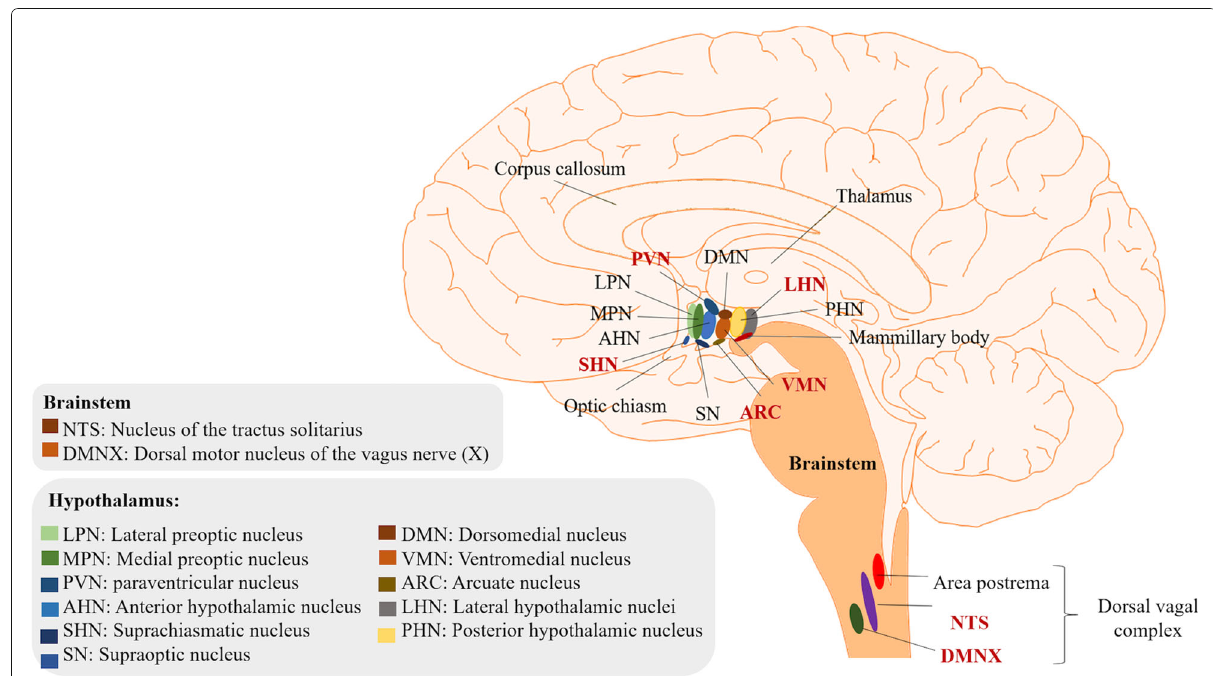
Fig. 1 Key hypothalamic nuclei and other areas involved in glucose homeostasis. Representation of a sagittal section of a human brain, where the most relevant nuclei of the hypothalamus and the brain stem involved in control of glucose production and uptake are depicted